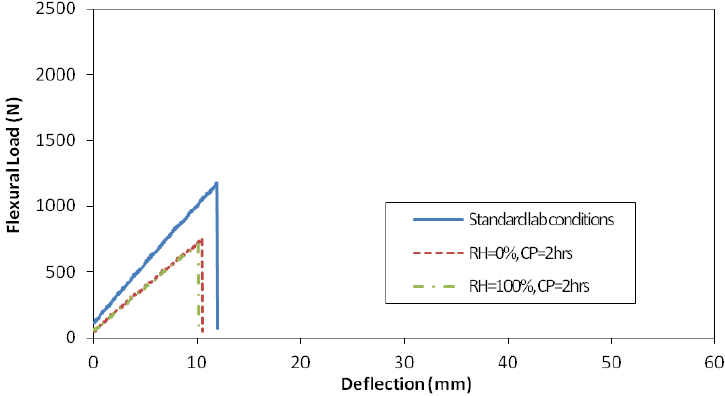
Figure 8. Flexural load-mid span deflection curves after 40 cycles under the conditions of 180 °C, 2-h cycle period, humidity (0% and 100%).